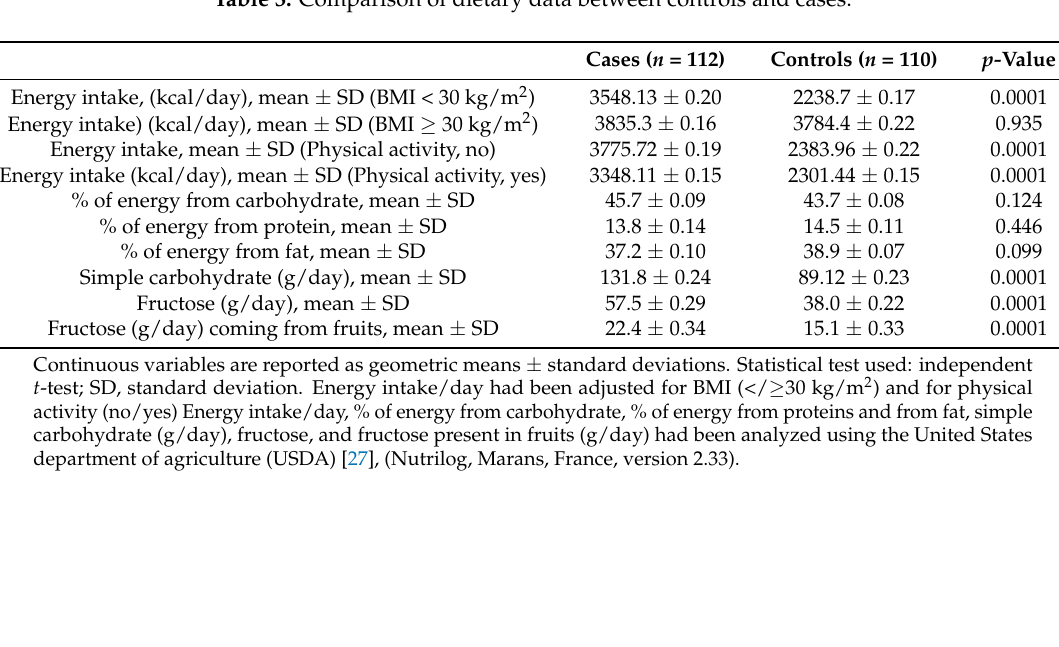
Table 3. Comparison of dietary data between controls and